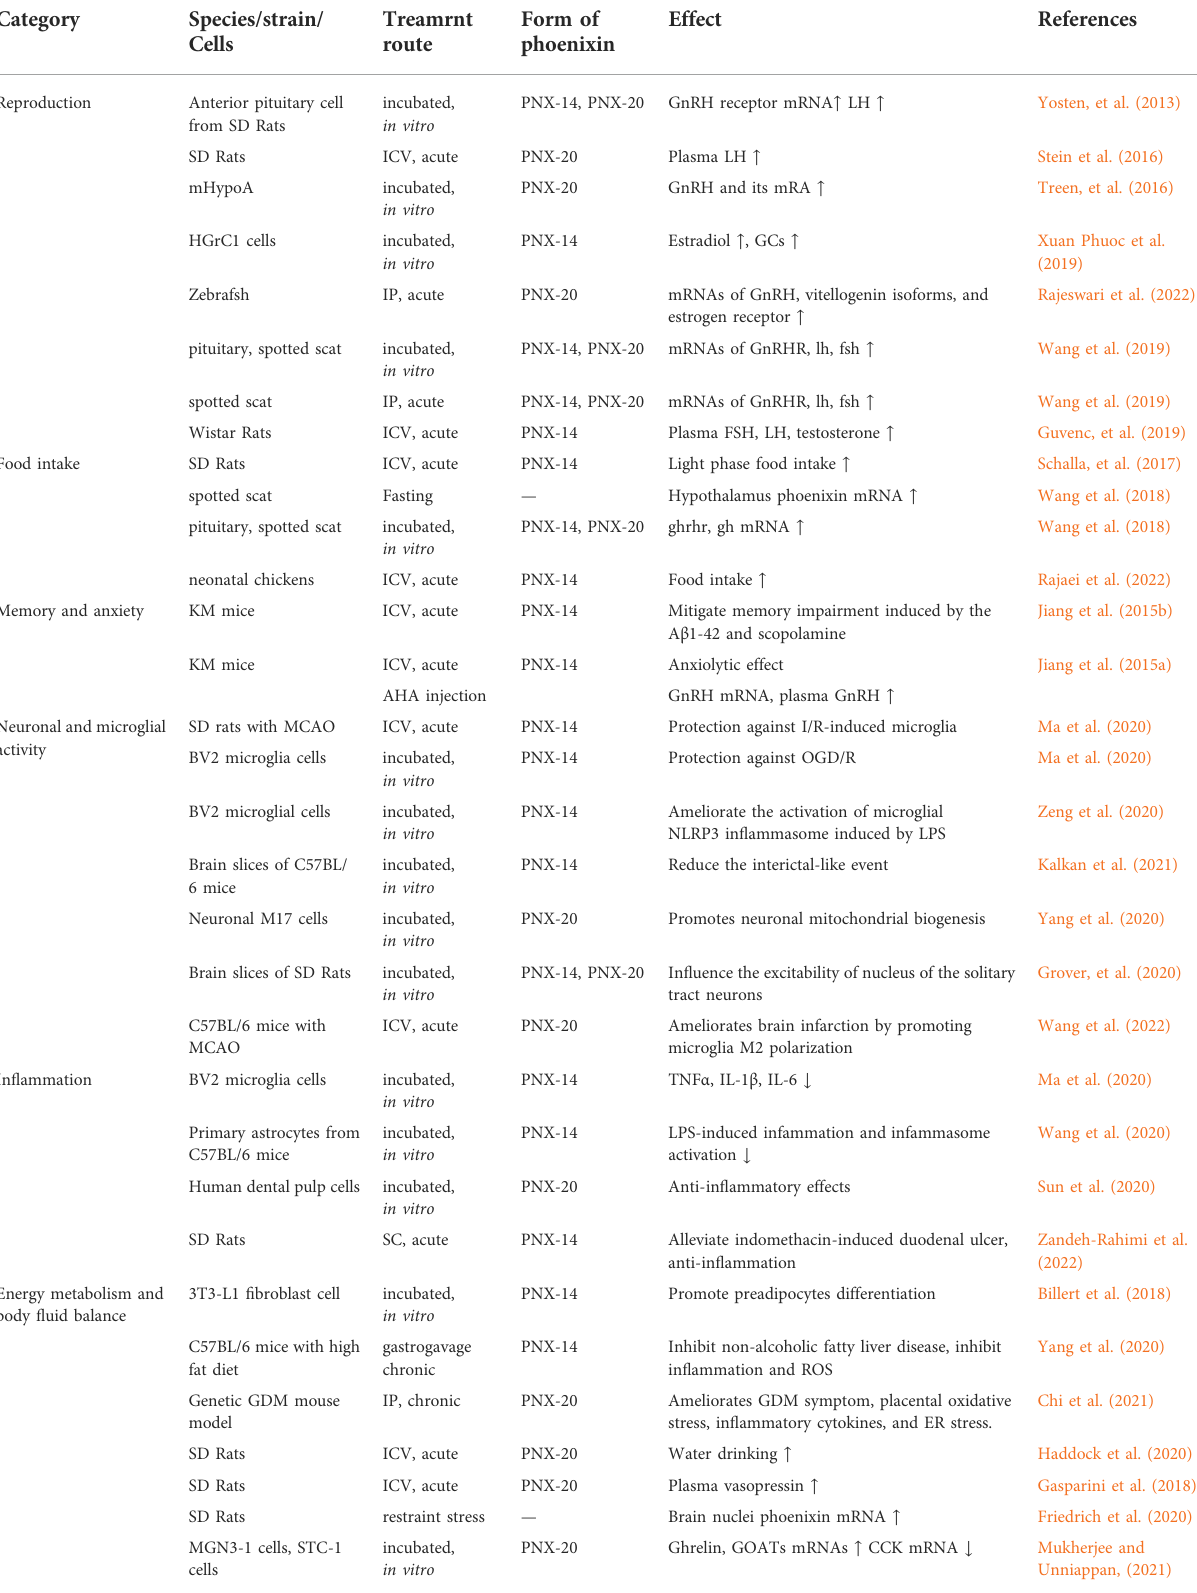
TABLE 1 Overview of the main function of phoenixin in recent